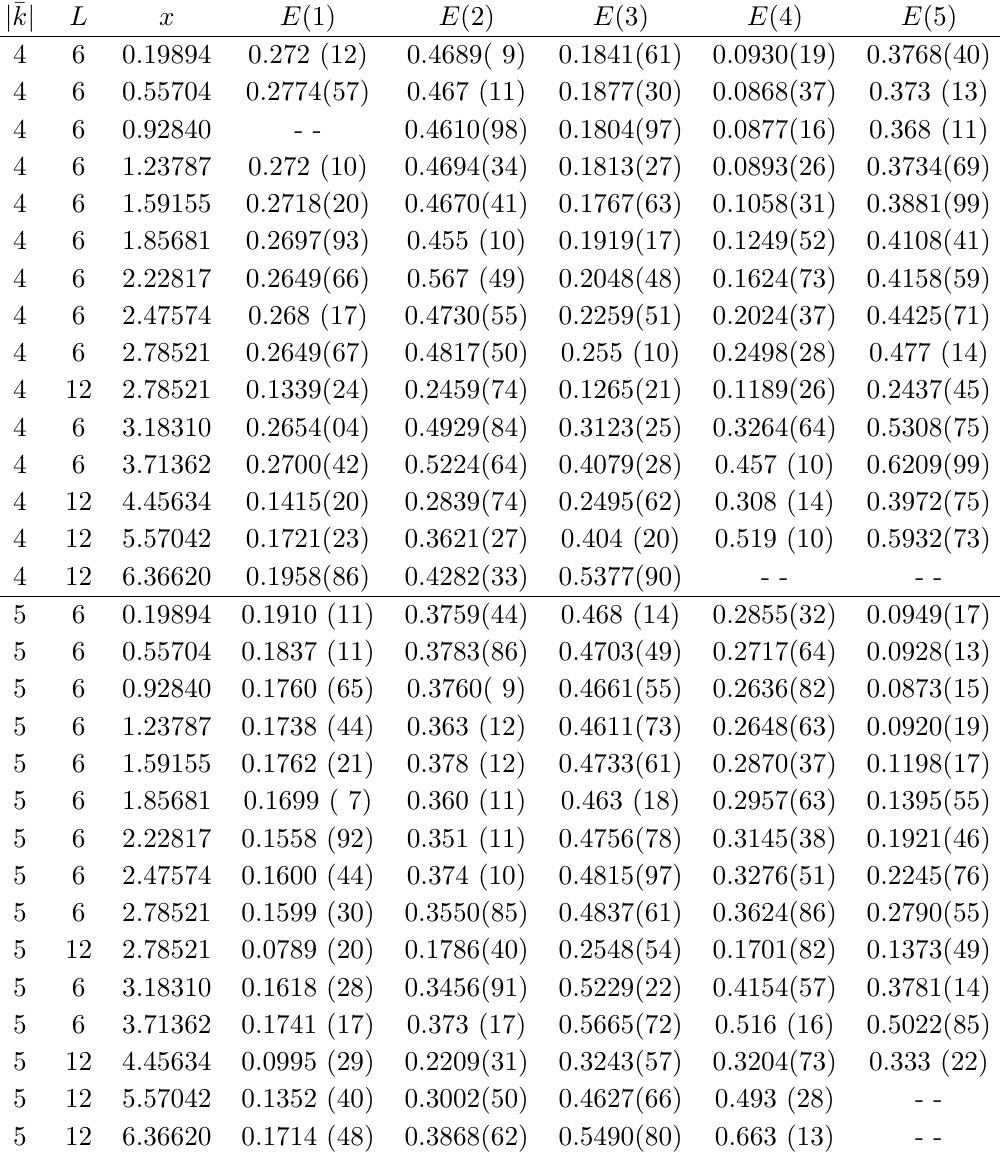
Table 7. SU(11) torelon energies (in lattice units)